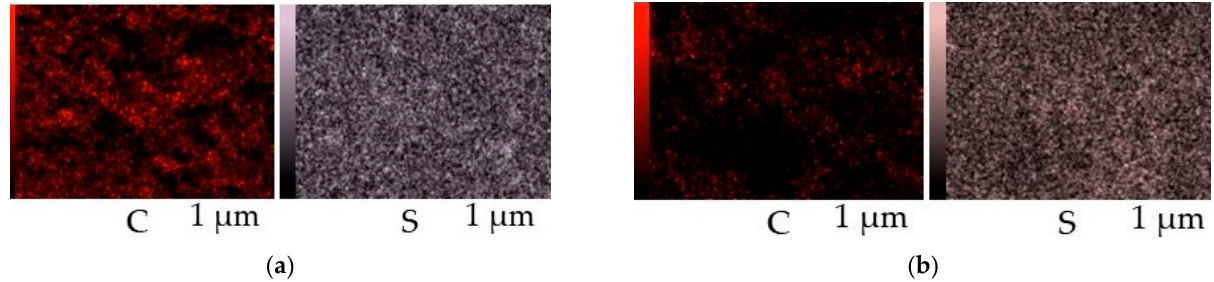
Figure 22. Photo of the fresh catalyst obtained during scanning electron microscopy (SEM). The dislocations of sulfur (S) and carbon (C) in the catalyst structure, evaluated by SEM, are shown in Figures 23 and 24.